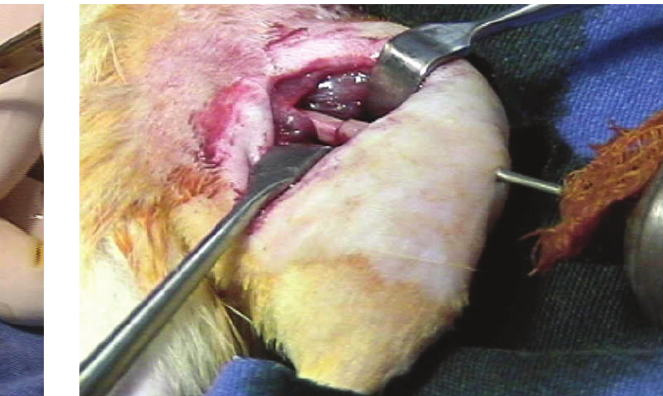
Figure 4 - Internal fixation of the femur with intramedullary nail